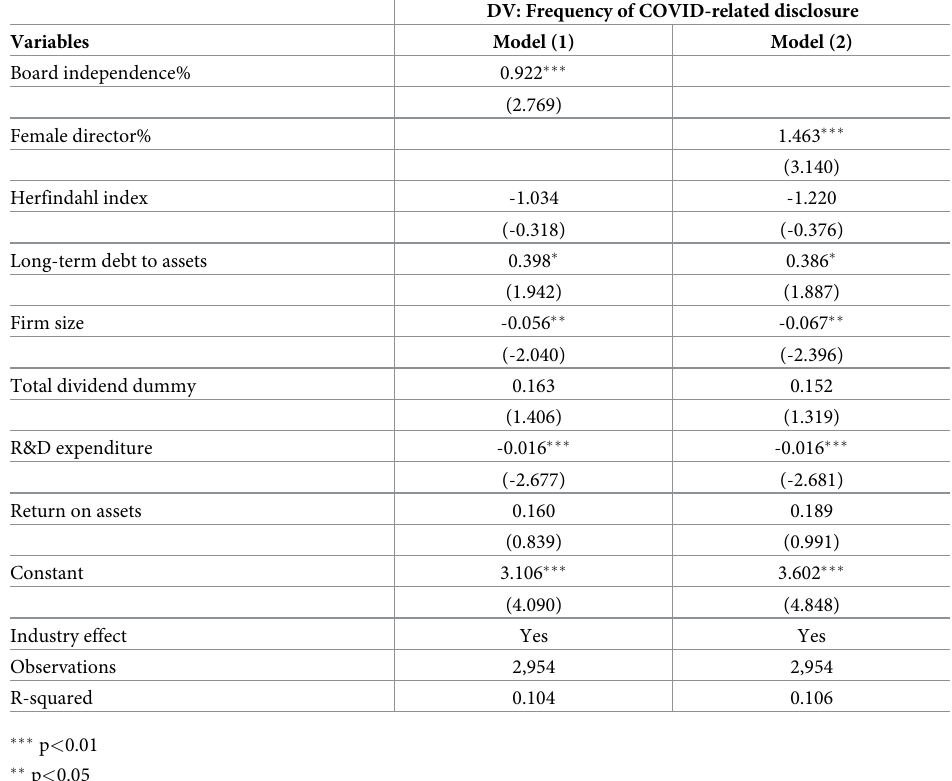
Table 7. Relationship between governance characteristics and frequency of COVID-related